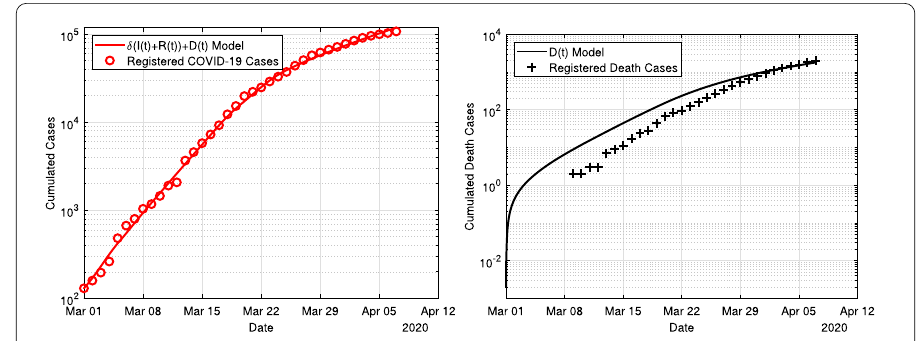
Figure 6 Fit of the time-dependent model (3a)–(3e) to the data for the period 1 March to 7 April